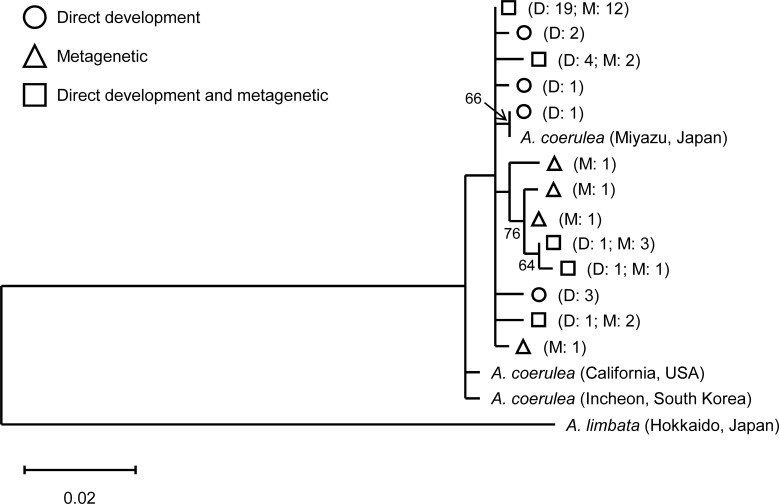
COI phylogenetic relationships among Aurelia of the two life cycle types in Maizuru Bay and A. coerulea from the North Pacific.The tree with the highest log likelihood (-862.22) is shown. Circle, triangle, and square indicate haplotypes that include specimens from the direct-development period, metagenetic period, and both periods, respectively. The letters following the symbols indicate the number of specimens from the direct-development (D) and metagenetic types (M). Bootstrap values > 50% are shown adjacent to branches. The scale bar indicates the number of substitutions per site. A. limbata was used as an outgroup.